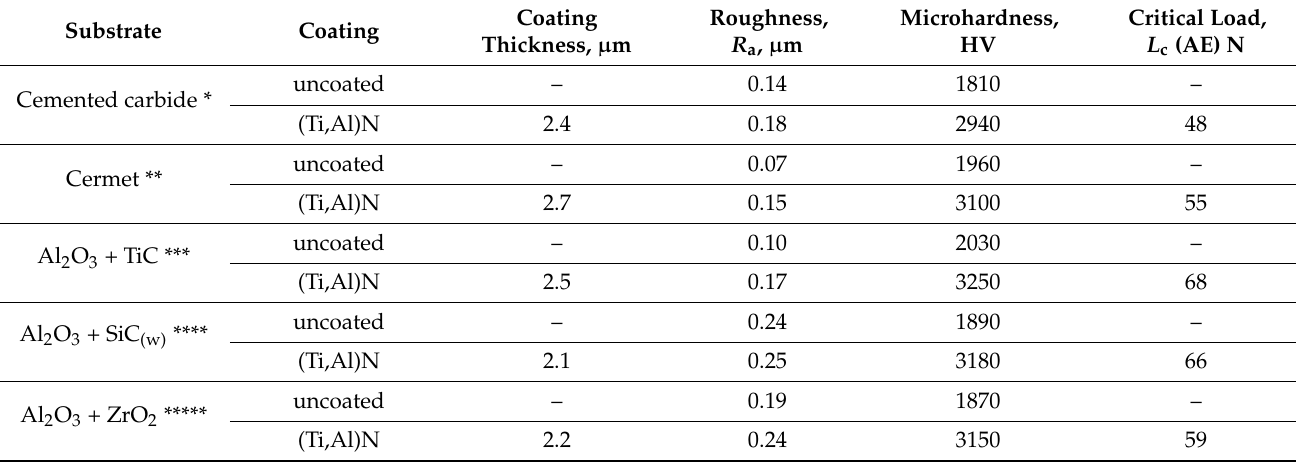
Table 1. Characteristics of the investigated